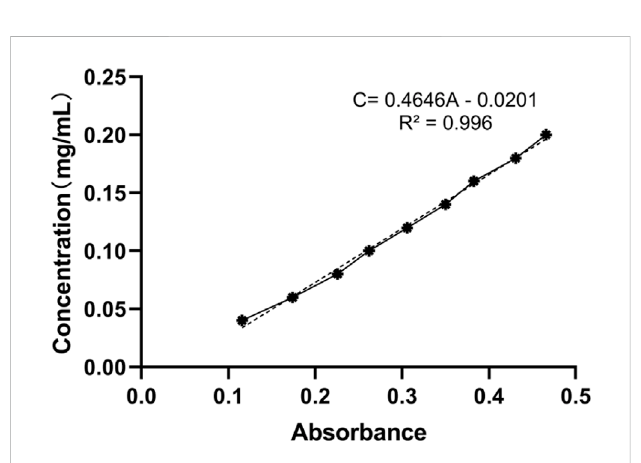
FIGURE 10 Solubility standard curve of Samoamide